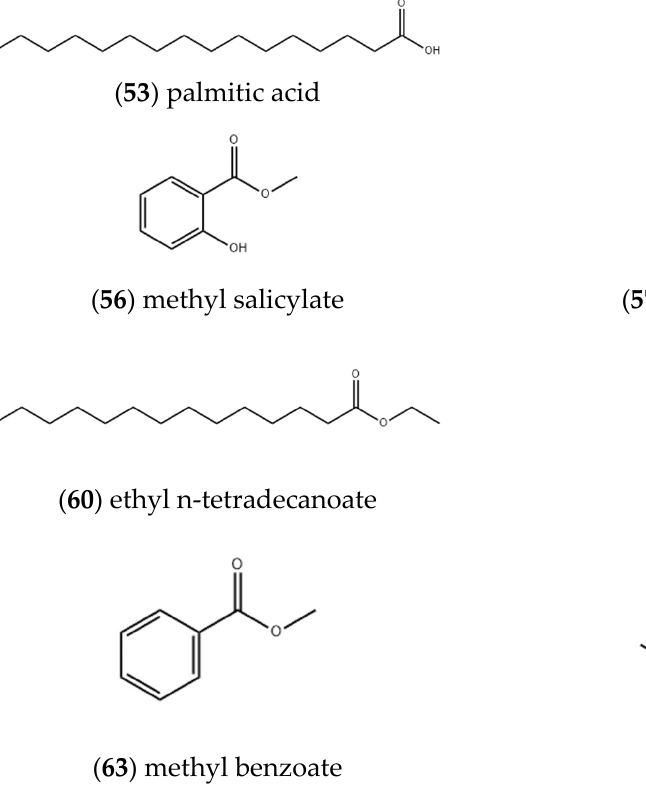
Figure 5. Structures of alcohols and phenolic compounds isolated from ST .